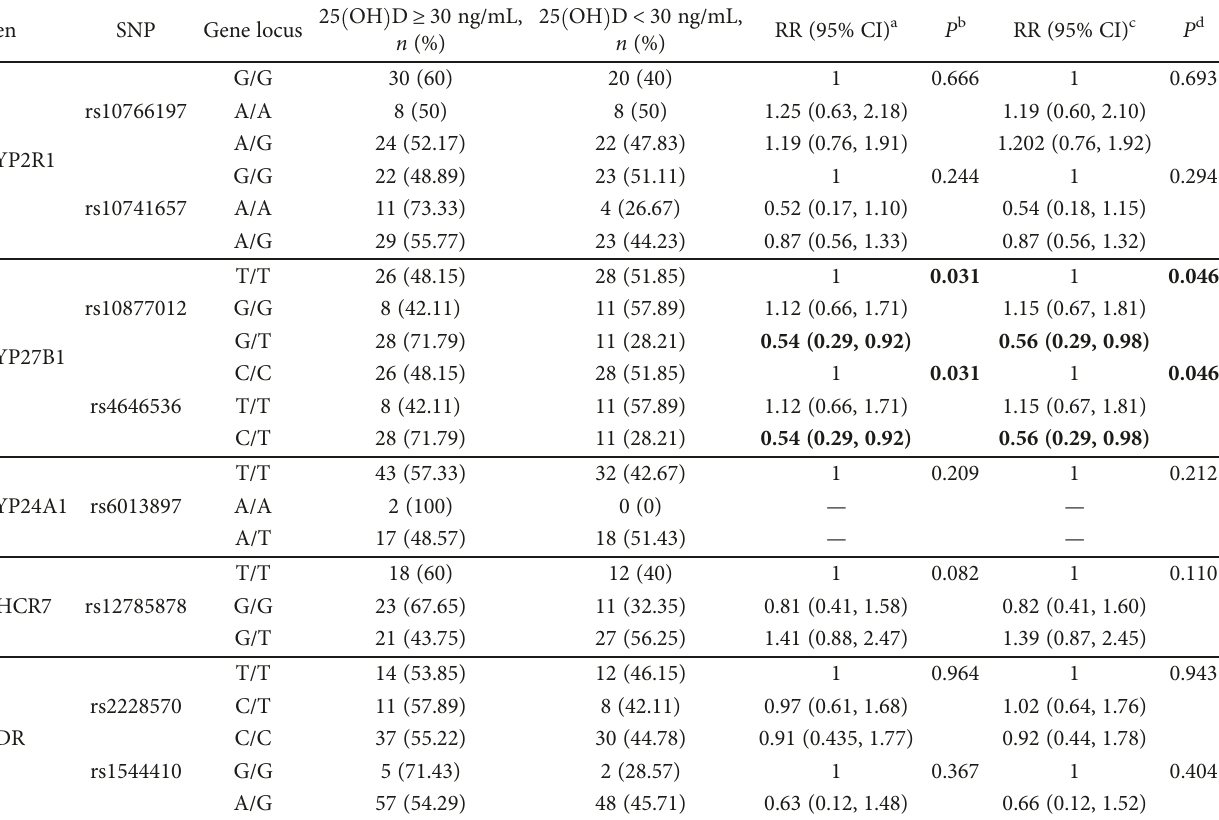
supplementation. 3